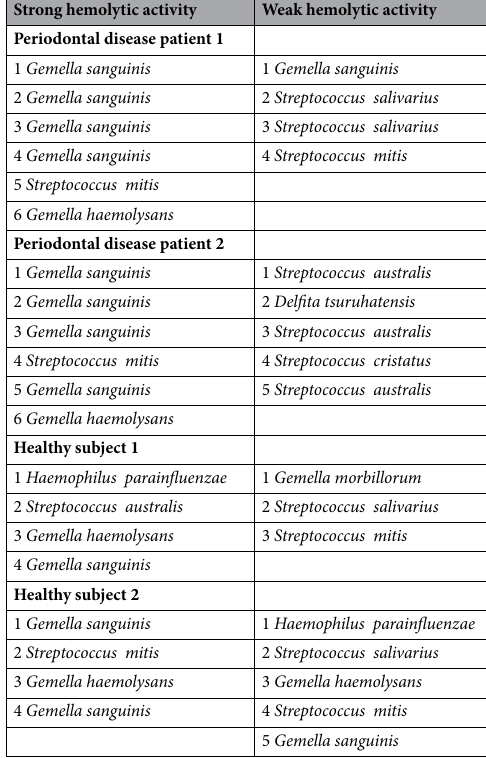
Table 2. Bacterial species of colonies with hemolytic